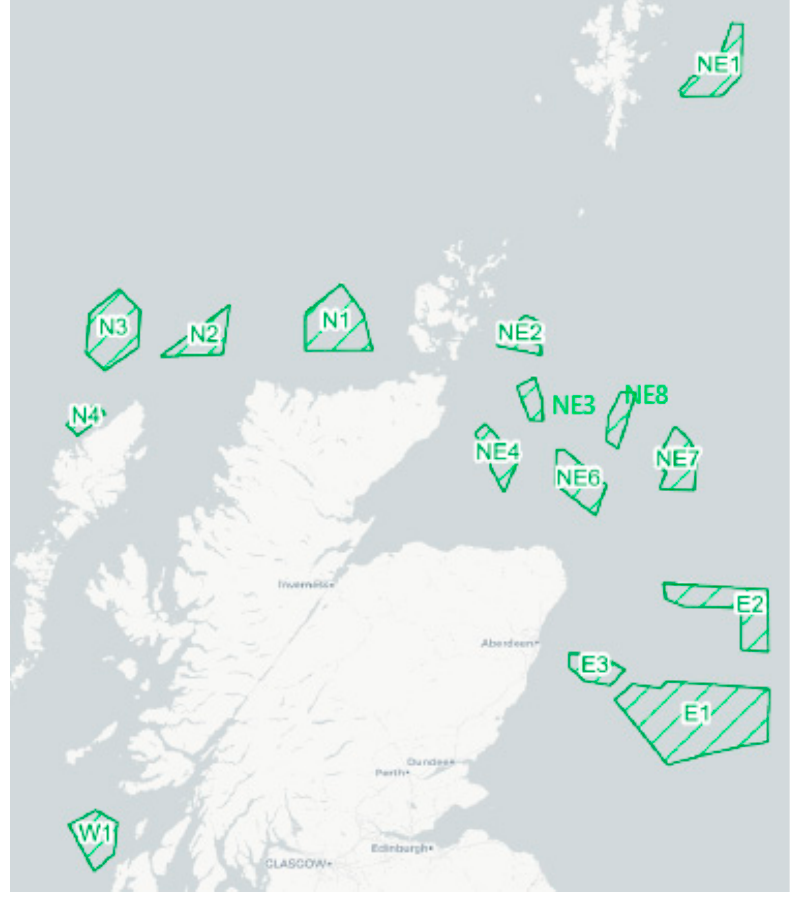
Figure 3. Map of proposed Scotwind sites [31].